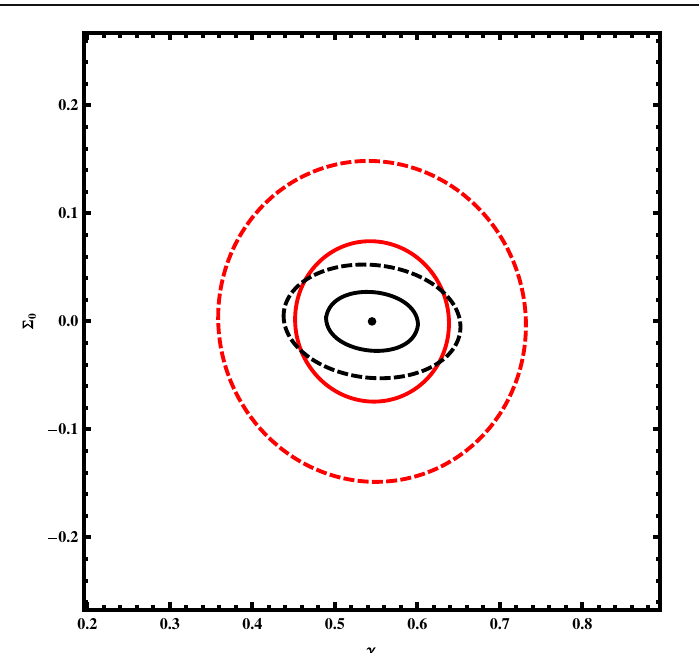
Fig.15 Marginalized γ − Σ 0 forecastforweaklensingonlyanalysiswithEuclid.Here, Σ 0 isdefinedfrom Σ = 1 + Σ Σ , defined via Eq. (I.3.28), is related to the WL potential. Black contours correspond 0 a and to (cid:23) max = 5000, demonstrating an error of 0.089 ( 1 σ) on Σ 0 , whereas the red contours correspond to (cid:23) max = 500 giving an error of 0.034. In both cases, the inner and outer contours are 1 σ and 2 σ respectively. GR resides at [0.55, 0], while DGP resides at [0.68,